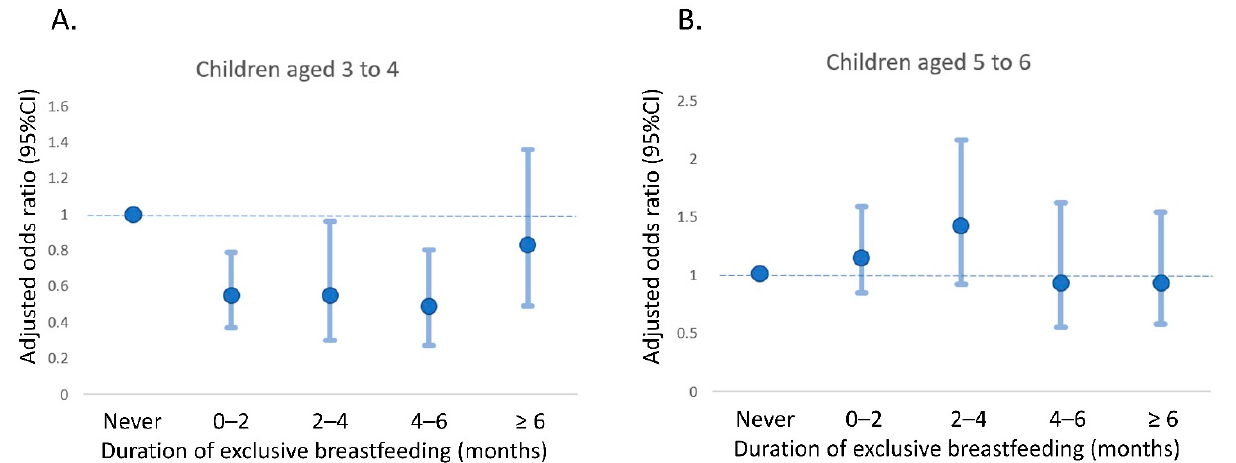
Figure 2. Association of exclusive breastmilk feeding duration with risk of asthma by age. ( A ) children aged 3 to 4 months; ( B ) children aged 5 to 6 months.